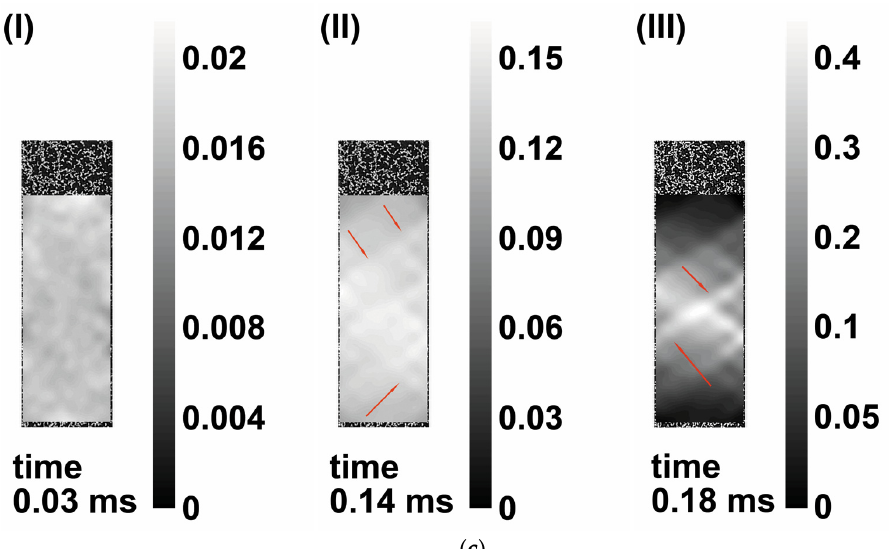
Figure 5. Fields of equivalent strain of smooth specimens at ( a ) 0.1 s − 1 , ( b ) 100 s − 1 , and ( c ) 1000 s − 1 .